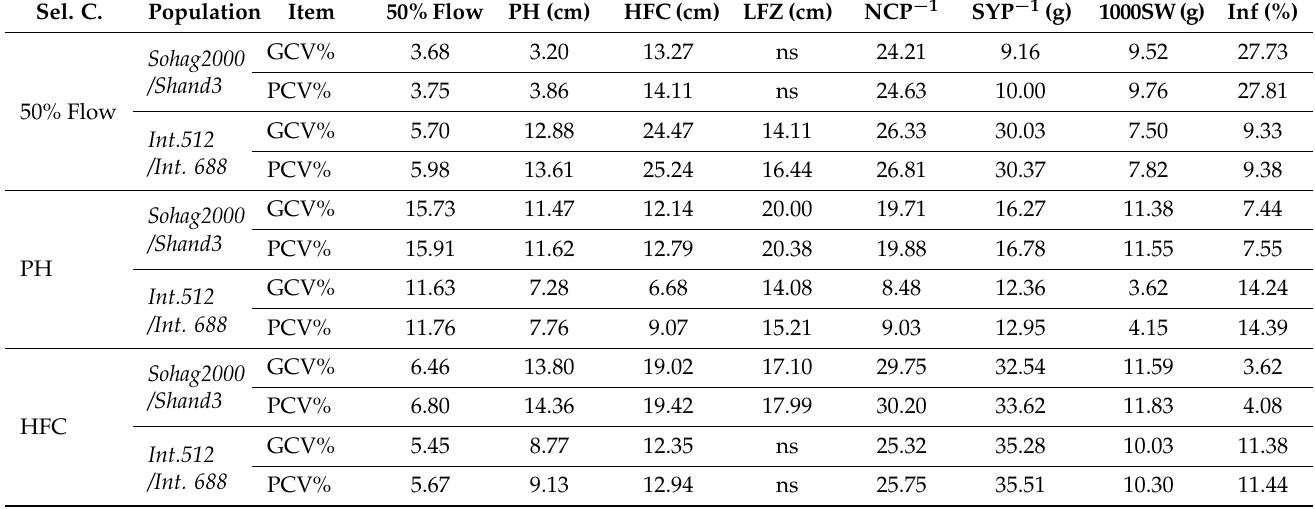
Table 4. Genotypic (GCV%) and phenotypic (PCV%) coefficients of variation for the studied traits for the two populations in the F 4 -